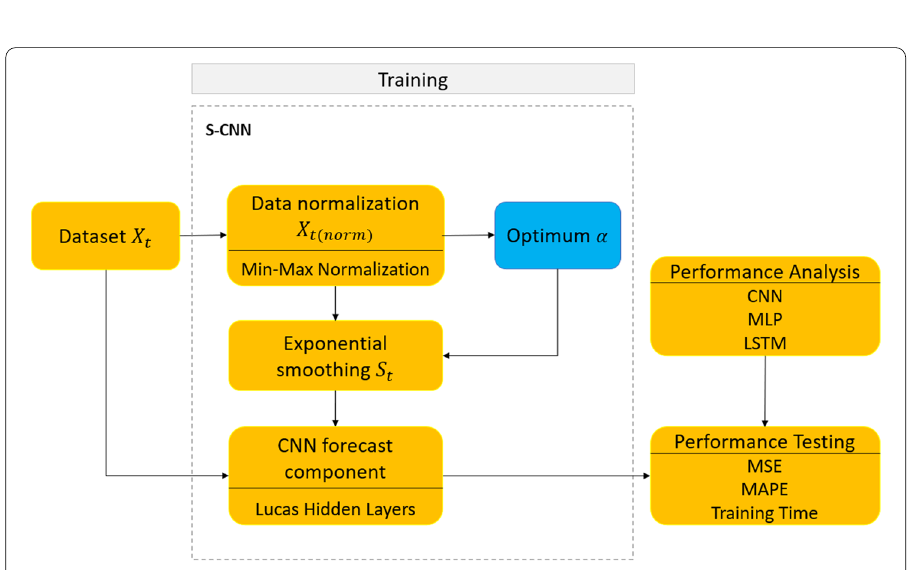
Fig. 1 Experimental design of Smoothed-CNN (S-CNN) with optimum